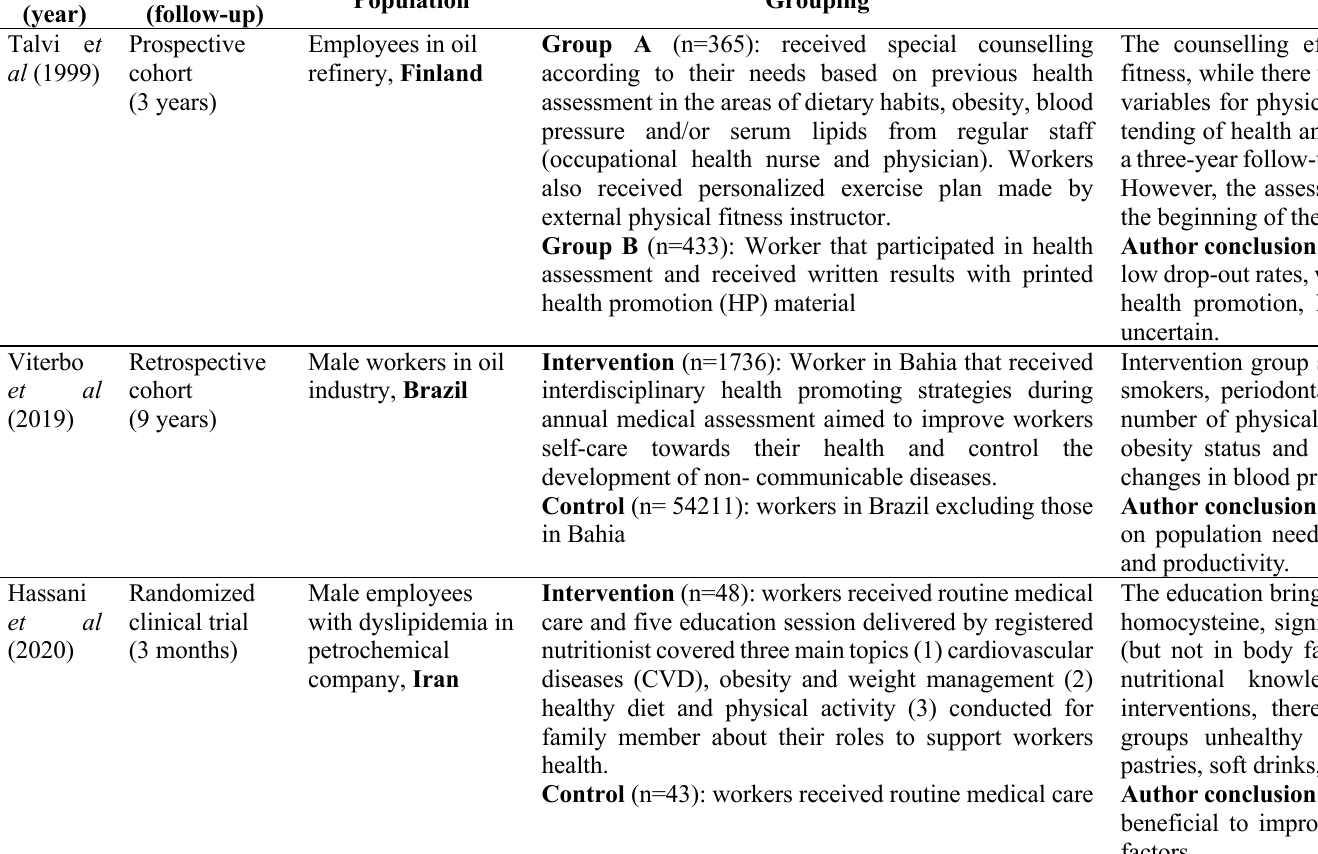
Table 3. Studies done to improve diet and obesity status in oil and gas